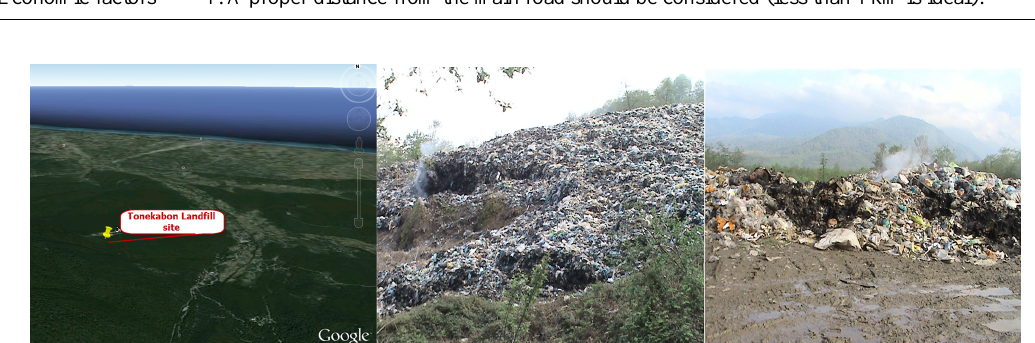
Figure 2. Location of and conditions at the Tonekabon landfill